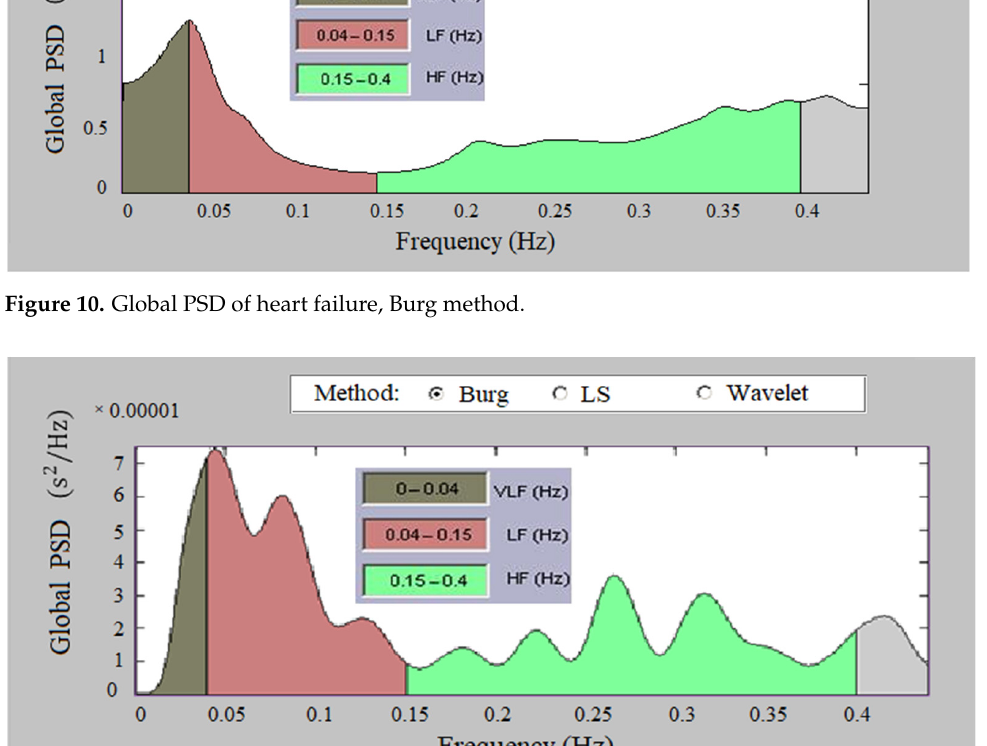
Figure 12. Dynamics of the values of the sympathovagal balance index (heart failure). 3.3. Surface Method